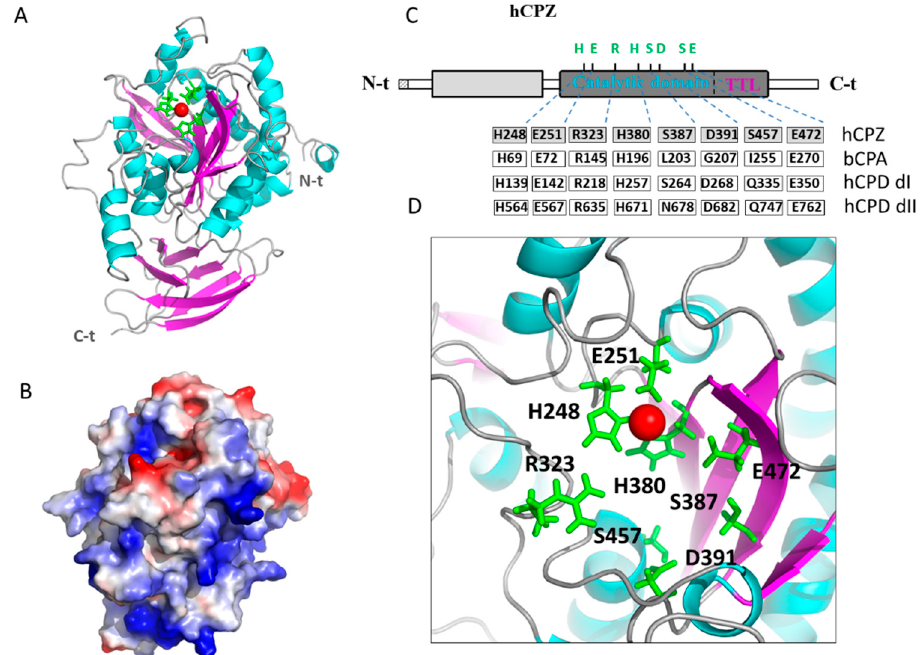
Figure 8. Structural modeling of the catalytic and transthyretin-like (TTL) domains of human CPZ. ( A ) Ribbon representation of human CPZ structure showing the central catalytic moiety at the top and the C-terminal TTL domain at the bottom. The side chains of the three residues involved in the Zn 2 + binding (i.e., His248 Glu251, His380) are indicated in green; ( B ) Electrostatic surface potential distribution of the catalytic domain of human CPZ (in the same orientation as panel A). Blue indicates positive and red indicates negative charge potential; ( C ) Linear representation of the full-length human CPZ, showing the location of relevant amino acids involved in the catalytic mechanism and substrate binding (Arg323, Ser387, Asp391, Ser457, and Glu472), as well as in zinc binding (His248 Glu251, His380). Residues found in equivalent positions in bovine CPA (bCPA, as reference), in domain I of human CPD (hCPDdI) and domain II of human CPD (hCPDdII) are indicated; ( D ) Magnification of the active site of human CPZ, showing the location of these residues important for the catalytic mechanism and substrate specificity determination. The Zn 2 + metal ion is shown in all representations as a red sphere.